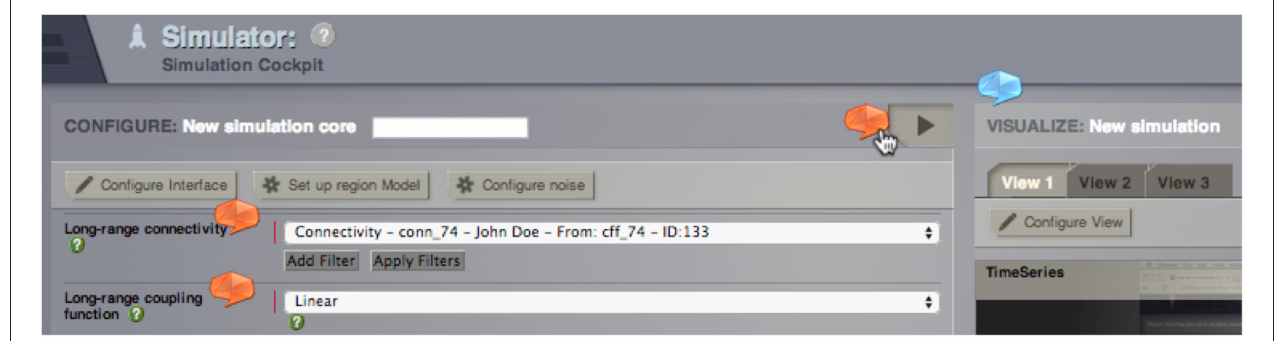
FIGURE 4 | Section of TVB Simulator interface with integrated parameter Helper Elements (red) and TVB-GUI Helper element (blue).